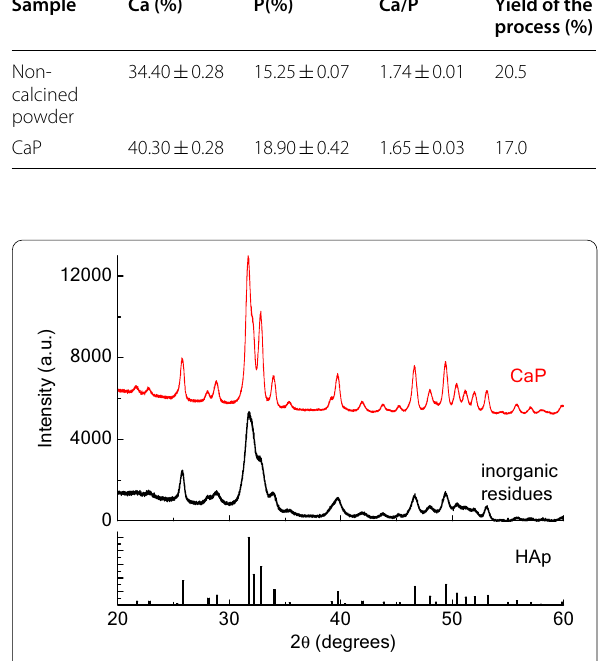
Fig. 4 XRD data for the inorganic residue (non-calcined powder) and the CaP sample. The patterns are compared to the 01-072-1234